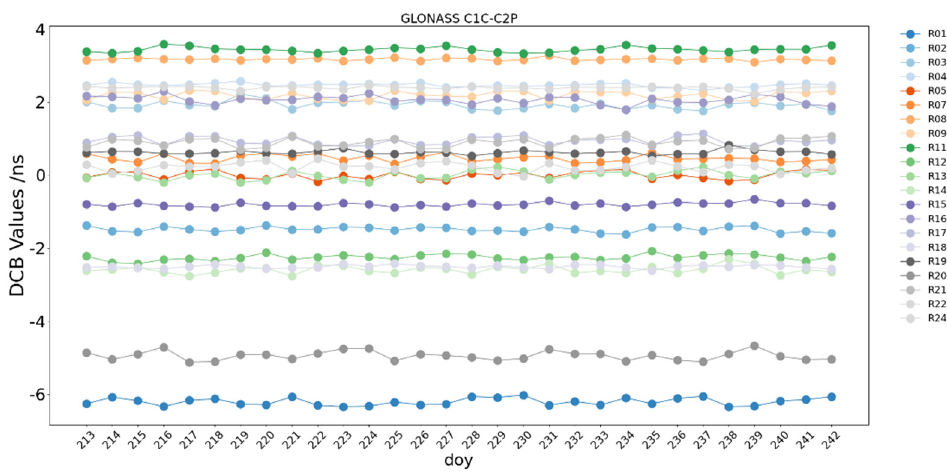
Figure 20. Comparison results between DCB and CAS products of GPS satellite.